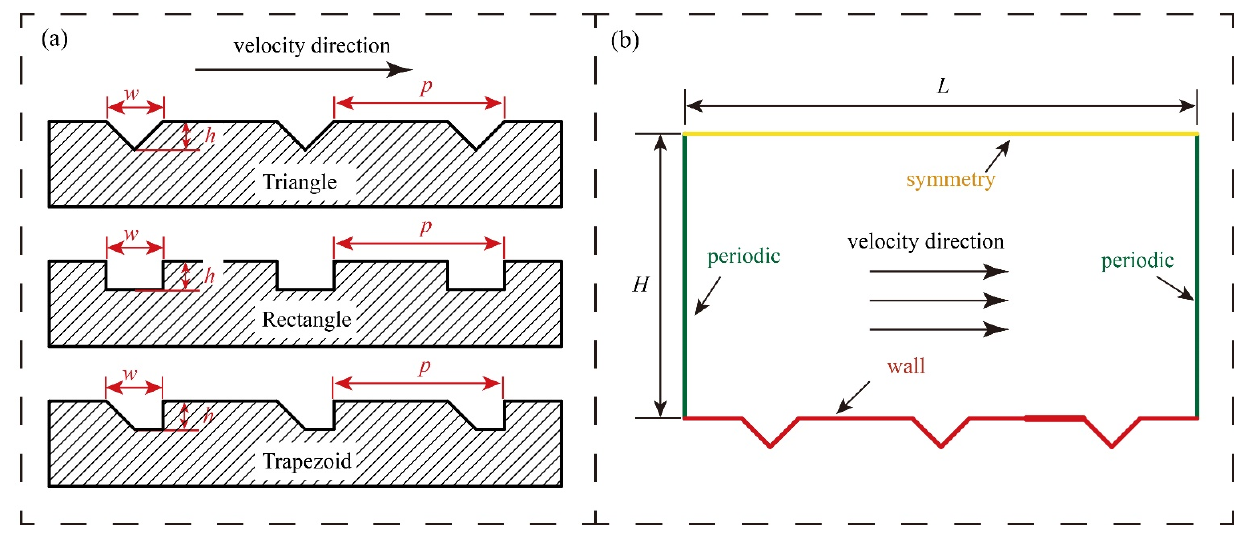
Figure 2. The geometric sketch of the spanwise groove and the computational domain of the CFD simulations: ( a ) the geometry parameters of three types of grooves; ( b ) the dimensions of computational domain and the boundary conditions. Table 1. The parameter values of spanwise groove in the simulations. (Unit: µ m).